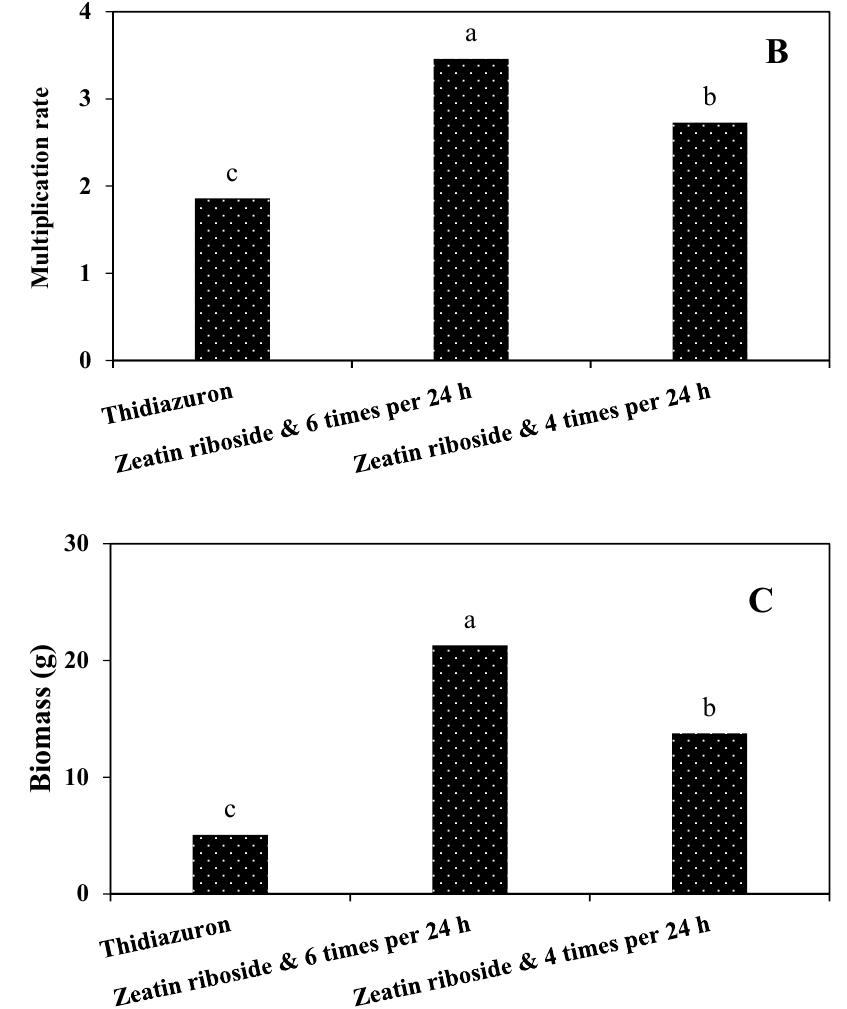
Figure 9. Mean comparison of the effect of thidiazuron (solid culture medium) and zeatin riboside in (TIB) and 4 times per 24 h feeding cycle on the length of the longest stem ( A ), multiplication rate ( B ), and biomass ( C ) of S. pennata seedlings. Bars with a common letter do not differ significantly from each other. p < 0.01 probability level (Duncan’s test).